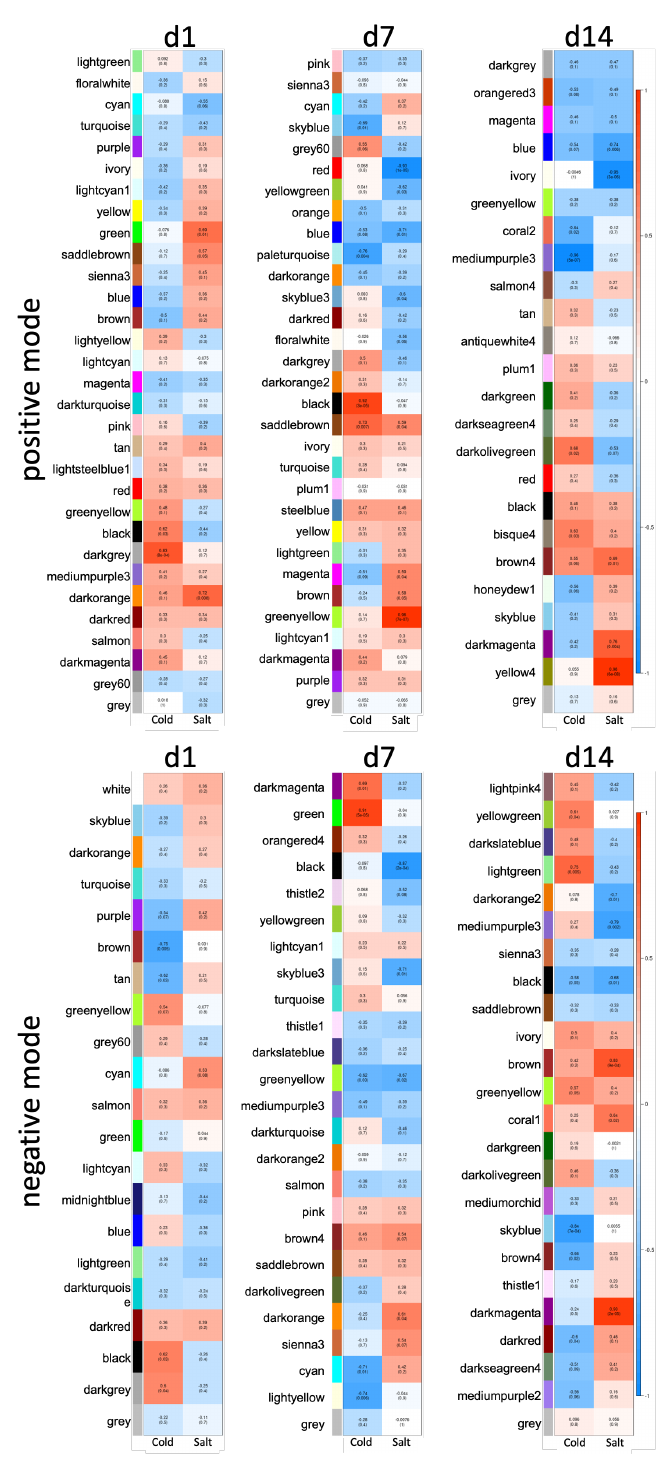
Figure A13. Module-trait correlation for the metabolome of CAP1035. Metabolic data (positive and negative mode) was used to perform a WGCNA . Shown here is the relationship for each identified cluster with the single stress chilling temperature (Cold), or salt (Salt) as indicated at d1, d7 or d14. On the y-axis, all identified modules are listed with their respective names. Color and number indicate the correlation between module and binary trait for eigengenes and numbers in brackets the p-Value for significance.